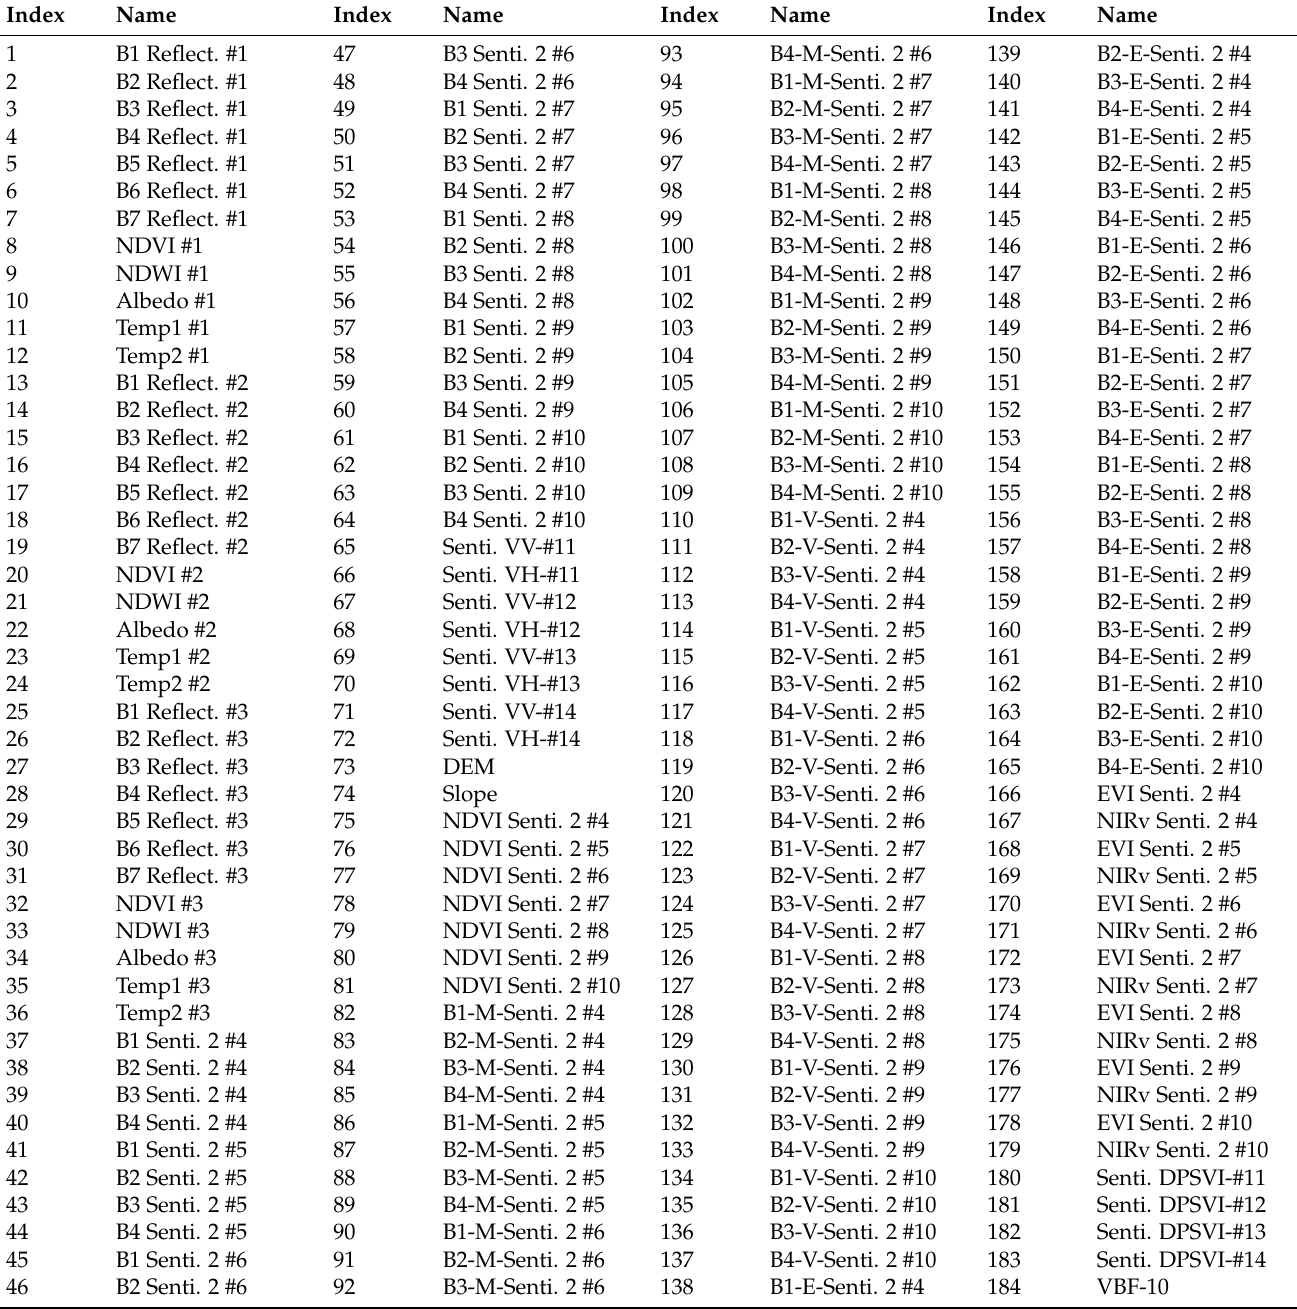
Table 3. Features used during this study and their associated variable index. Reflection is shortened to “Reflect.” and Sentinel is shortened to “Senti.” M, V, and E correspond to the mean, variance, and entropy texture, respectively. The number at the end of each feature name refers to the image ID